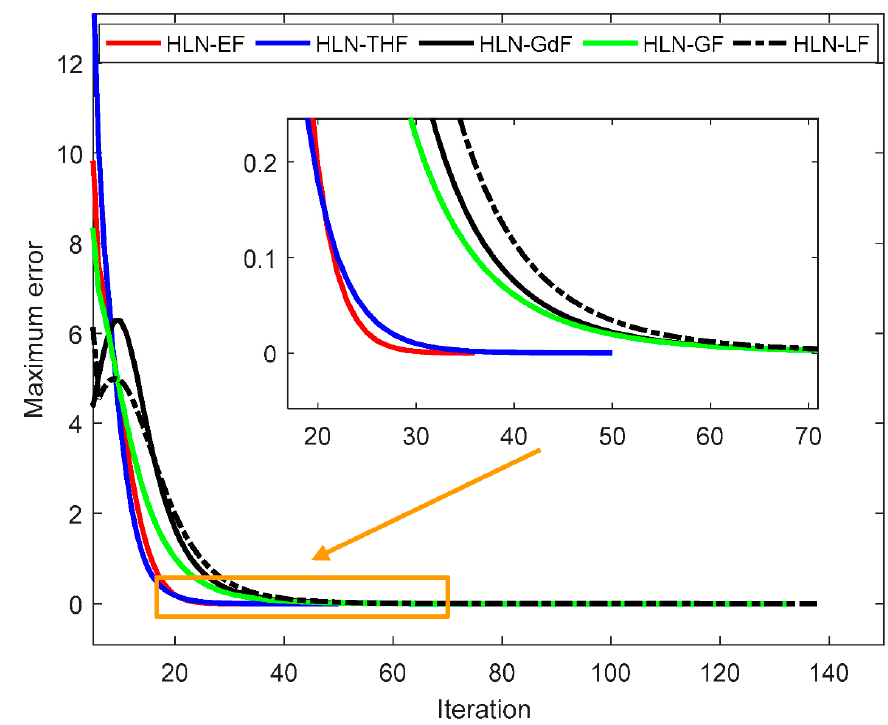
Figure 4. Maximum error vs. iteration for the first system with the first model of payment.